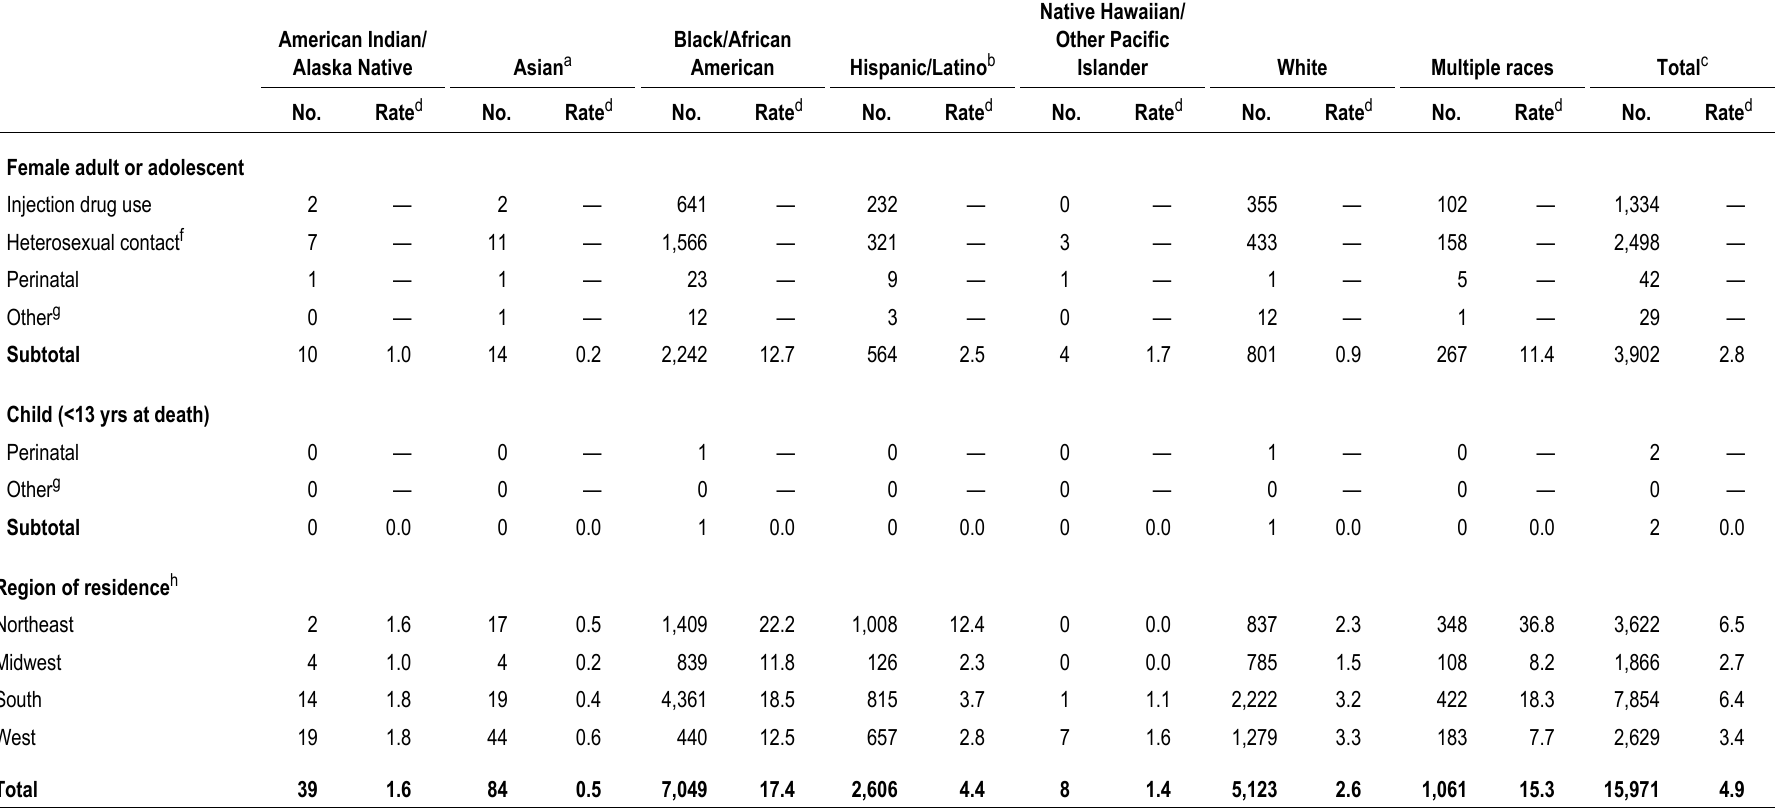
Table 20a. Deaths of persons with diagnosed HIV infection, by race/ethnicity and selected characteristics, 2017—United States